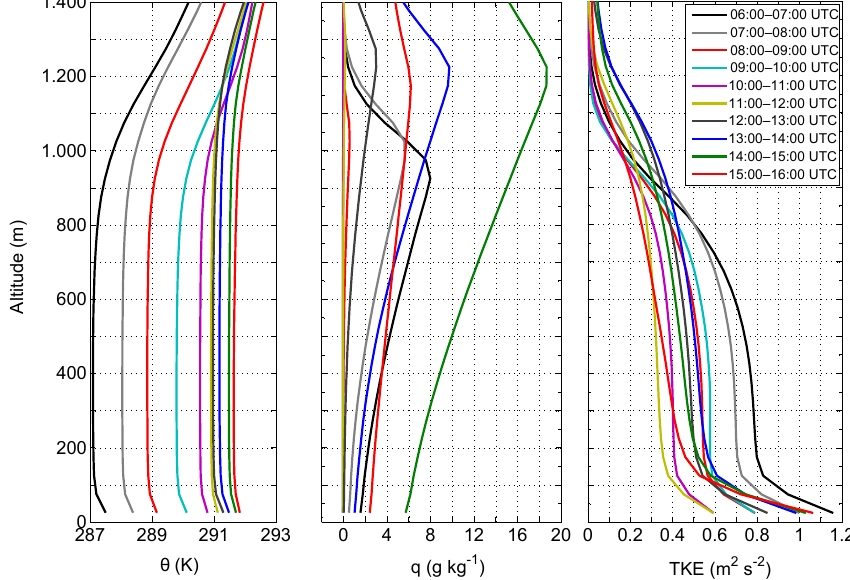
Figure 8. Potential temperature θ , water vapour mixing ratio q and turbulent kinetic energy TKE depending on the altitude, estimated with the LES model in 1h time intervals starting from 06:00 until 16:00UTC during the MelCol experiment on 21 June 2015. Highest values of q were estimated between the height of 950 and 1210m close to the inversion layer and appeared before sporadic NPF occurrence at